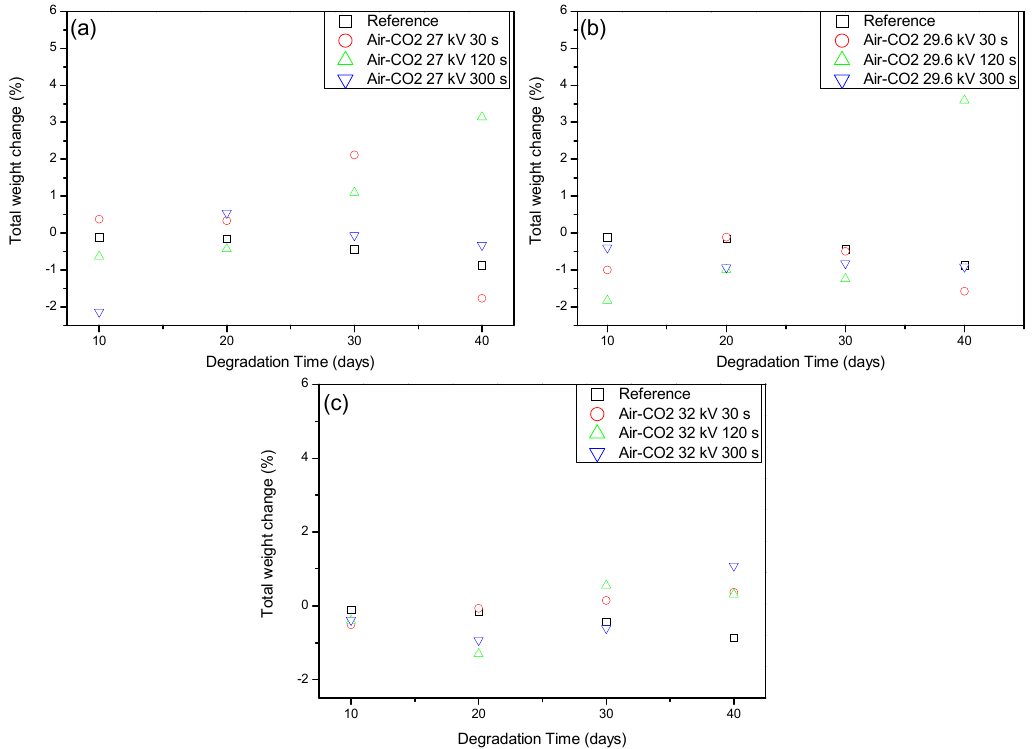
Figure 10. Percentage weight change of LDPE when introduced to the bacterial broth of Ps. aeruginosa for 10, 20, 30, and 40 days after being treated with plasma discharge containing ≈ 4% CO 2 in ambient air. These represent the percentage weight change in LDPE after degradation with plasma treatment times of 30, 120, and 300 s ( a ) shows changes for the different times at 27 kV ( b ) shows changes for the different times at 29.6 kV ( c ) shows changes for the different times at 32 kV